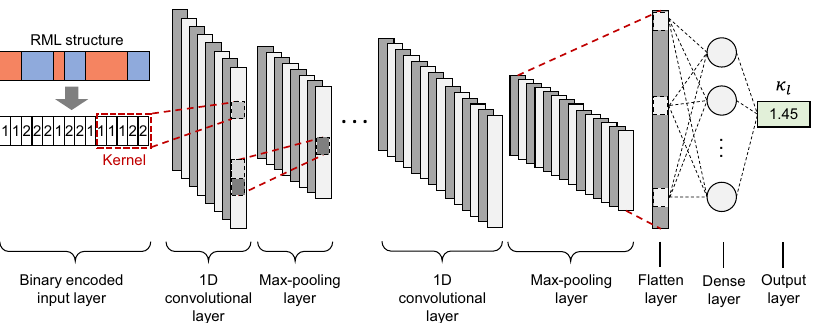
Fig. 6 Schematic of the convolutional neural network architecture. The SL or RML structure is encoded as a binary array and used as the input layer, while a single output node provides the predicted thermal